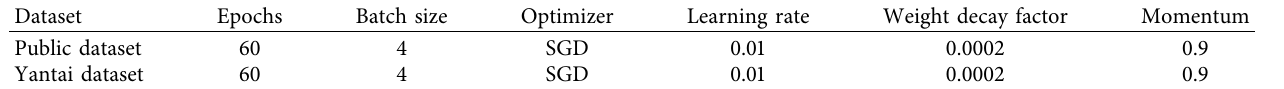
Table 2: Experimental settings.